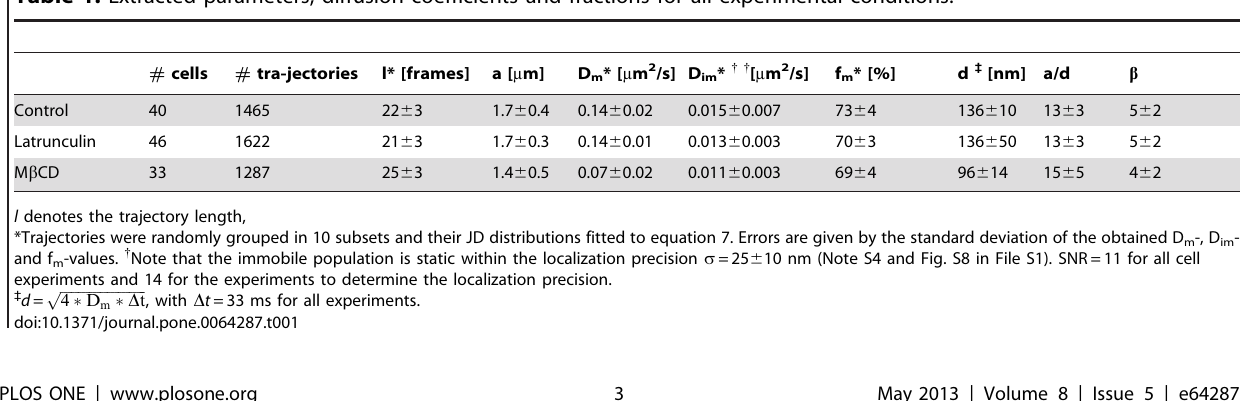
Table 1. Extracted parameters, diffusion coefficients and fractions for all experimental